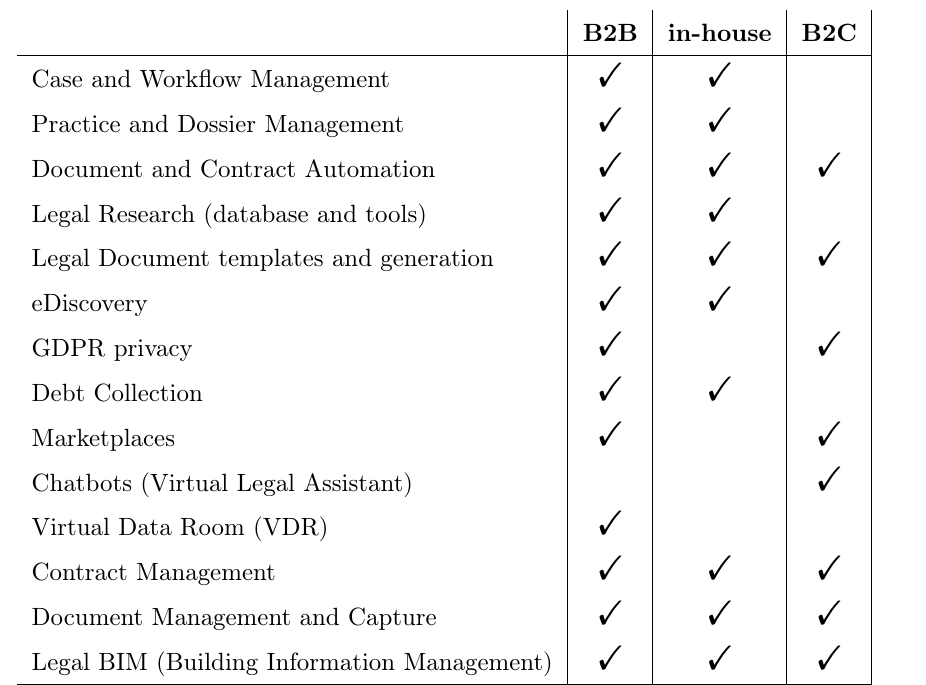
Table 1. Different types of LawTech applications and their markets